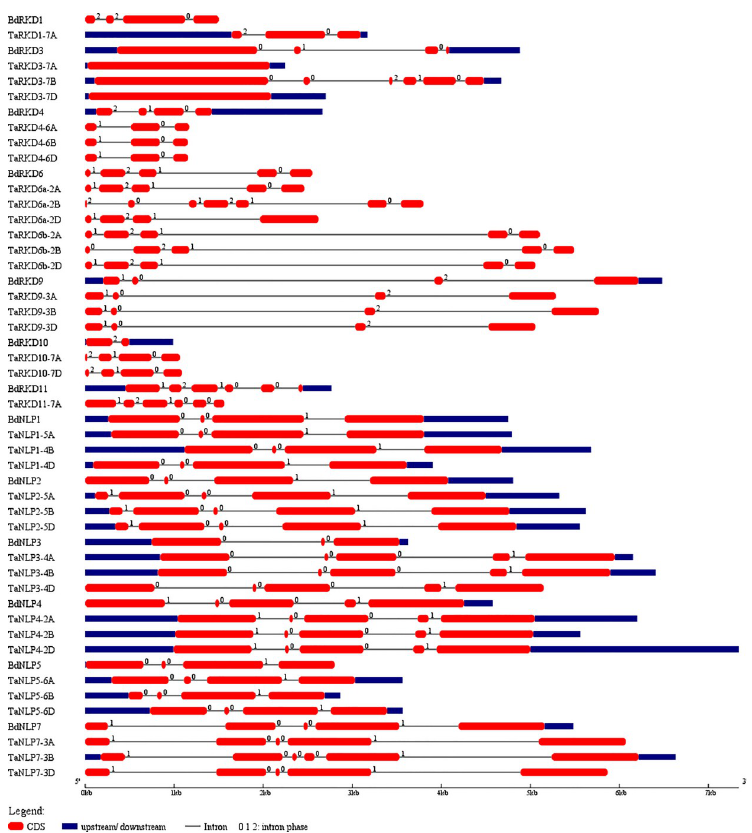
Fig 2. Structure of TaRKD and TaNLP genes showing distribution of exons (solid red bars), introns (black lines), upstream/downstream regions (solid blue bars) and intron phases marked as 0, 1 and 2.